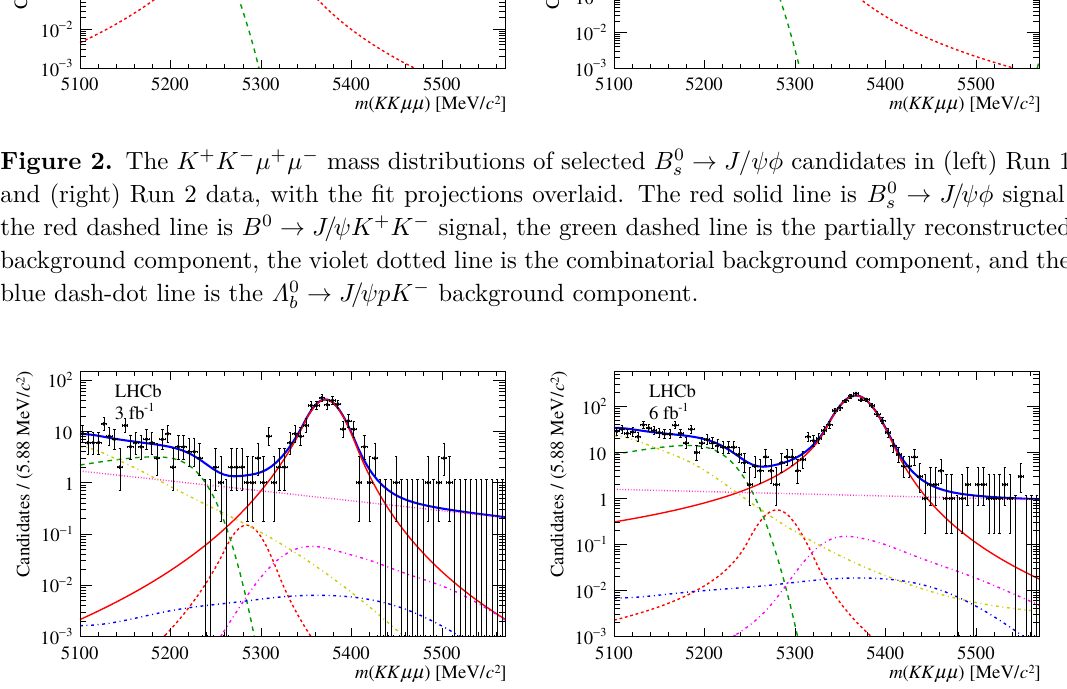
→ φµ + µ − candidates ( s ) → φµ + µ − signal, the red dashed line s → D − ( → φµ − ¯ ν ) µ + ν background s s